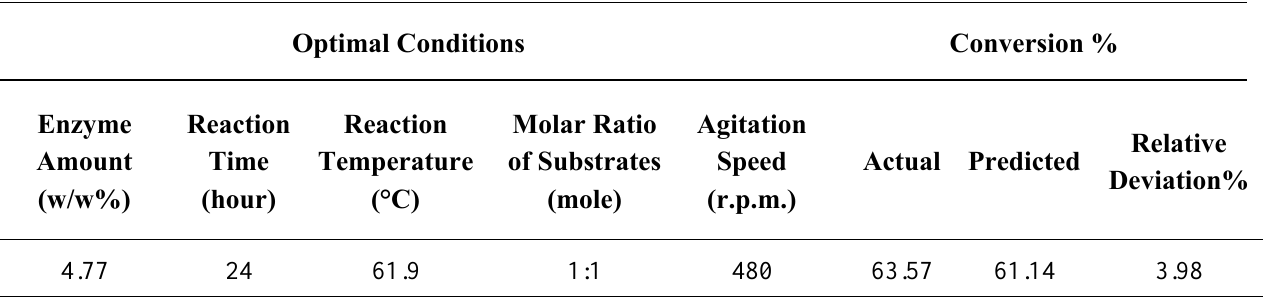
Table 2. Optimum conditions derived by central composite design and ANN for TEA-based esterquat cationic surfactant